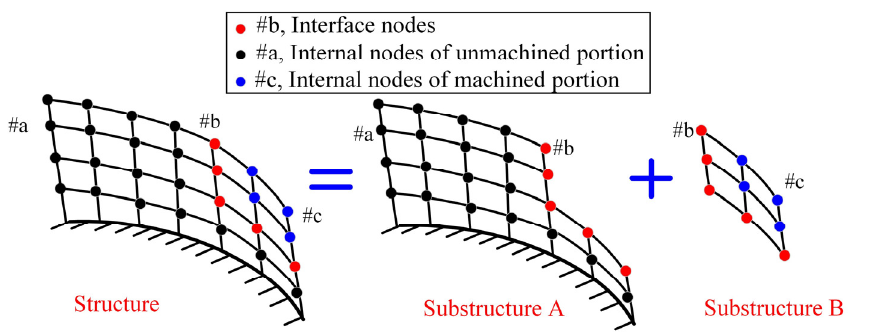
Figure 2. Coupling of